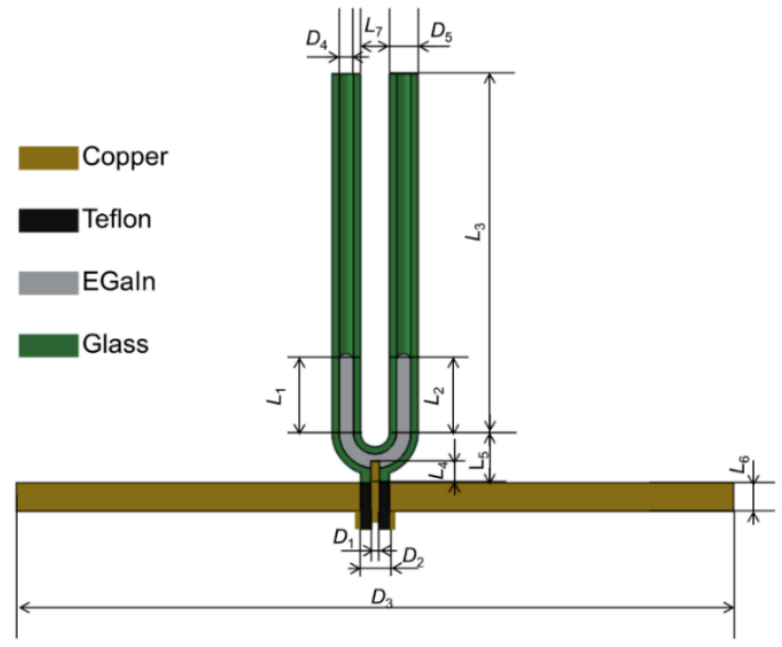
Figure 1. Front cross-sectional view of the antenna.